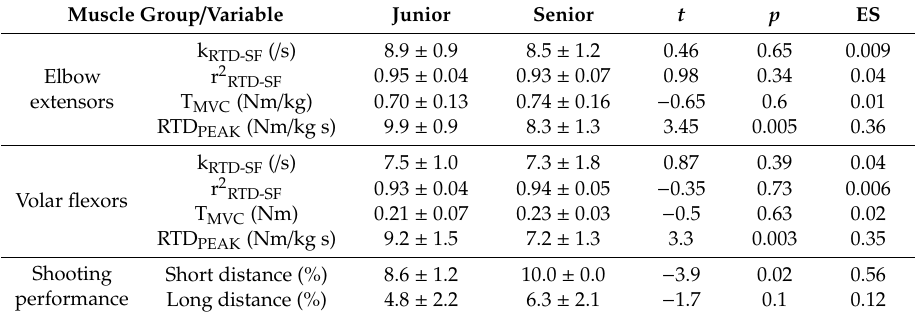
Table 3. Descriptive statistics and di ff erences in measured parameters between junior and senior basketball players.